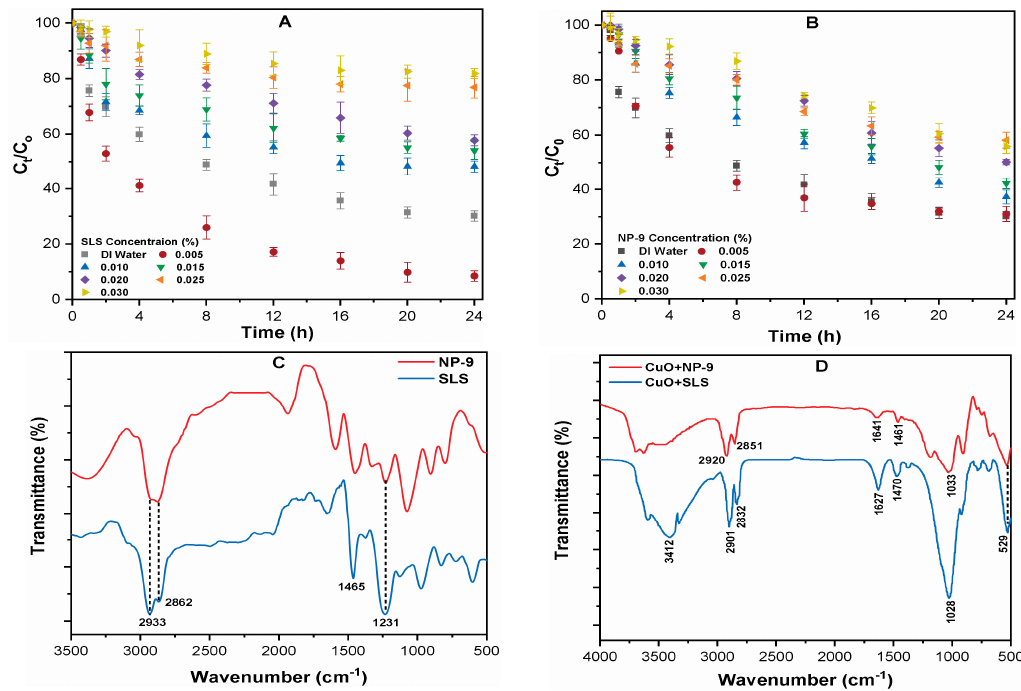
Figure 4. Effects of surfactants concentration (0–0.030%) on the aggregation rate of CuO NPs in the presence of ( A ) SLS; ( B ) NP-9; and FT-IR spectra showing ( C ) pristine surfactants and; ( D ) CuO-surfactants complex.